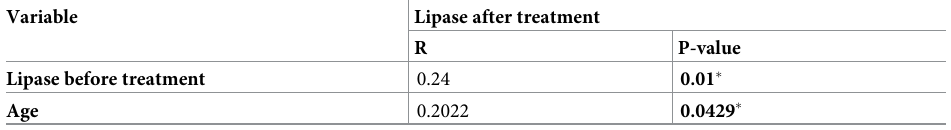
Table 5. Pearson correlation between serum pancreatic lipase at treatment of cure with base line lipase and age. Variable